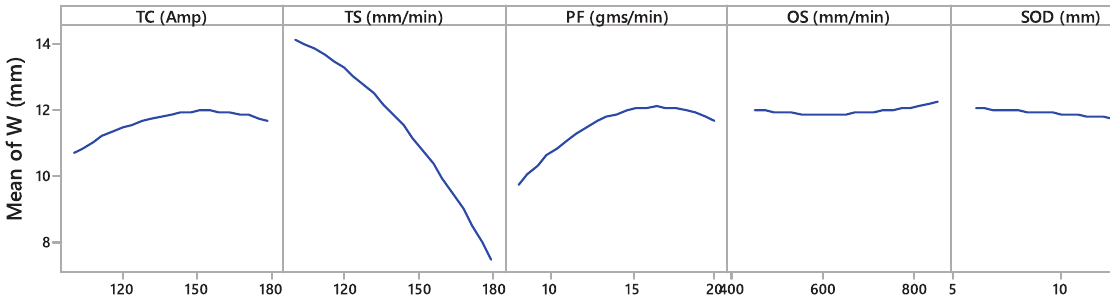
Figure 6: Main effects plot for width of deposition.